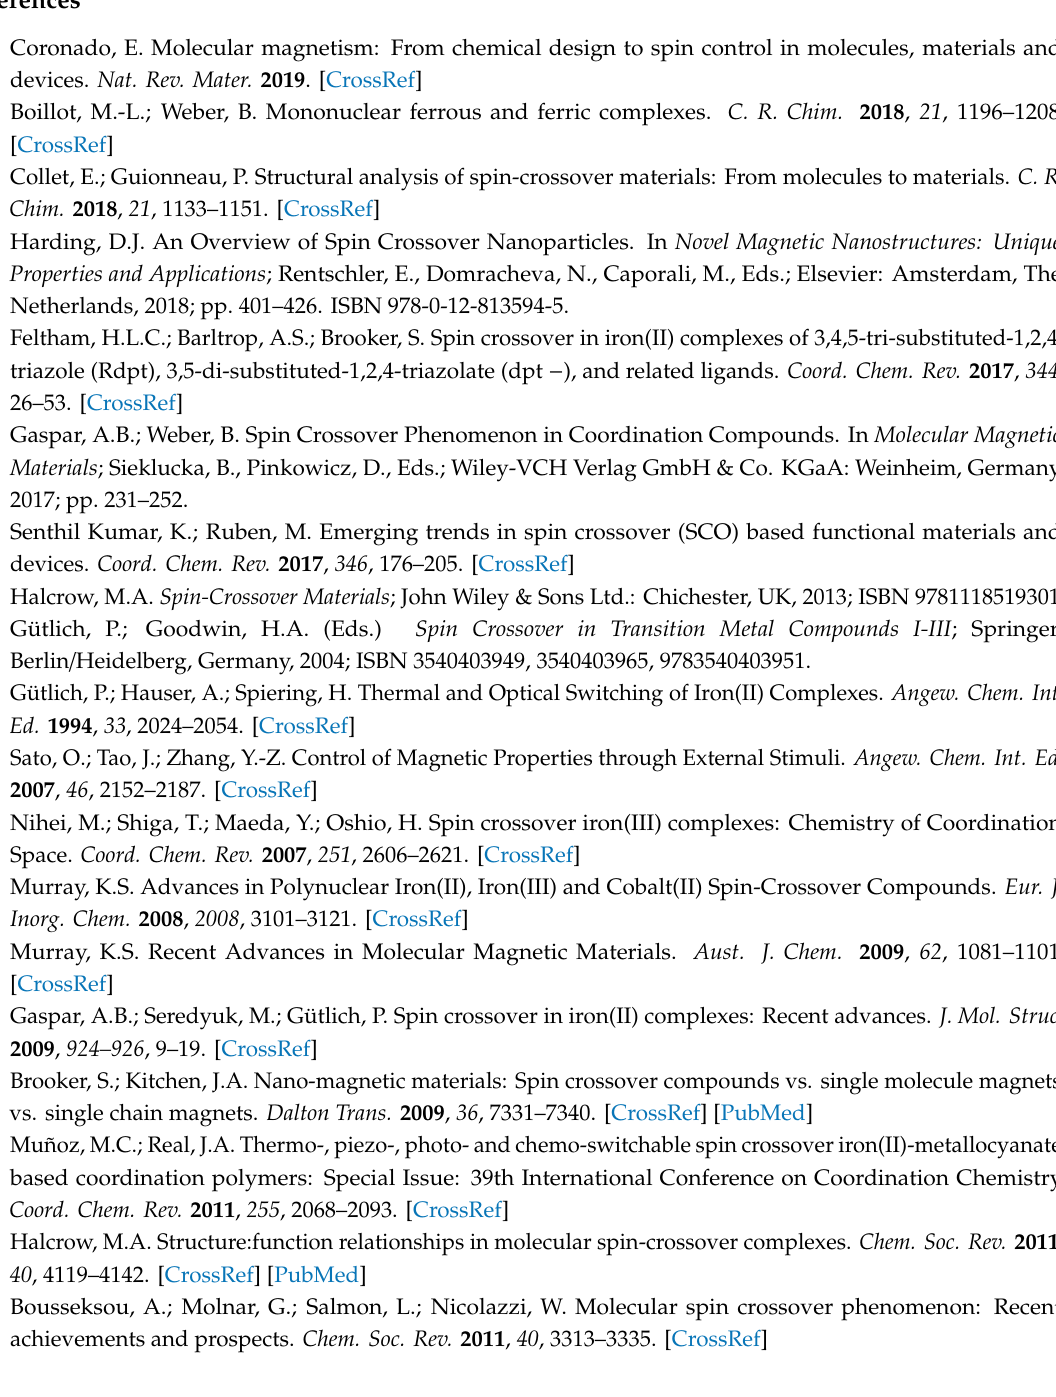
Supplementary Materials: The following are available online. Figure S1: ORTEP drawing of 3b displaying the disorder of one substituent. Ellipsoids are drawn at a 50% probability level. Hydrogen atoms were omitted for clarity; Figure S2: Plots of the χ M T product versus T (sweep measurements) for compounds 1a , 1b , 2 , and 3a ; Figure S3: Mössbauer spectra of 1a , 1b , 2 , and 3a ; Table S1: Crystallographic data of 1b and 3b ; Table S2: Mössbauer parameters of 1a , 1b , 2 , and 3a at room